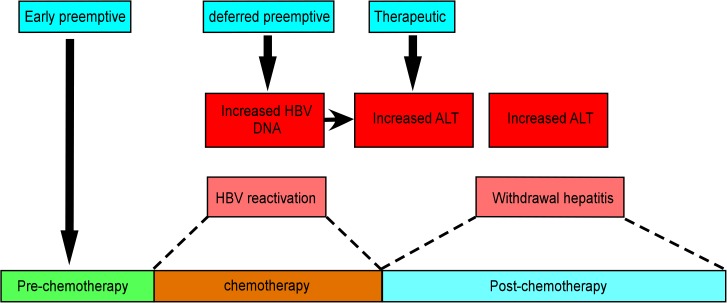
The proposed strategies to interfere with HBV during the chemotherapy in breast cancer patient.The phases of the patients had been divided into three stages; pre-chemotherapy, chemotherapy and post-chemotherapy. Lamivudine is given at the commencement of chemotherapy in early preemptive strategy and is given only after a significant rise of HBV DNA level in deferred preemptive strategy. If no early or deferred preemptive application of lamivudine had been given but the HBV DNA and ALT increased, the lamivudine applied to patients was used for therapeutic purpose.